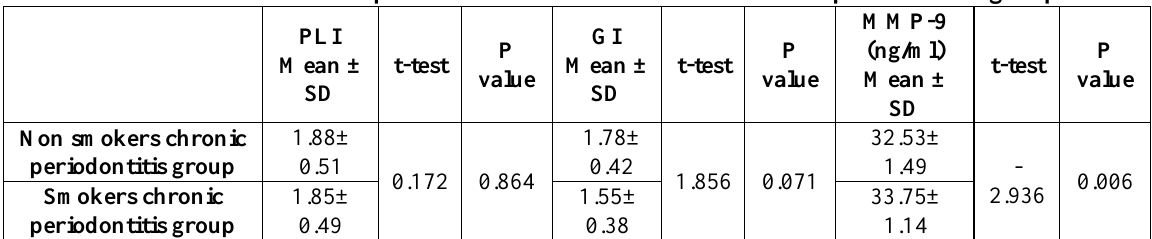
Table 1: Descriptive statistics (mean±SD) and inter group comparison of (PLI, GI and MMP-9) between smokers chronic periodontitis and non smokers chronic periodontitis groups